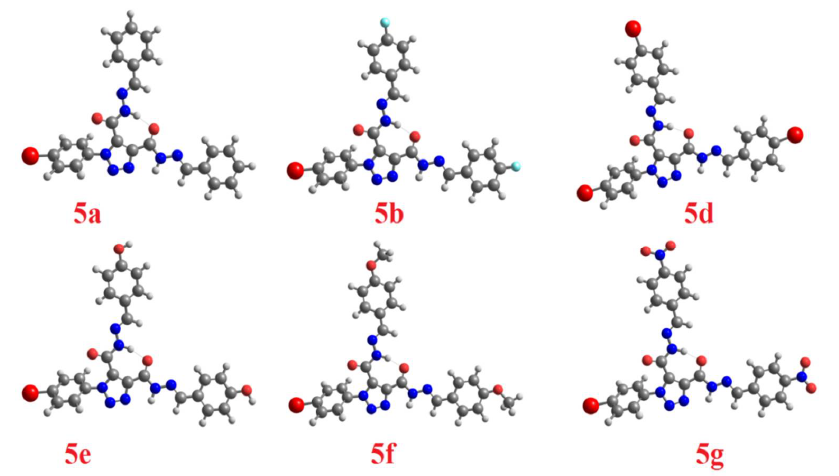
Figure 3. Calculated optimized molecular geometry of the trans - trans isomers of 5a – g .